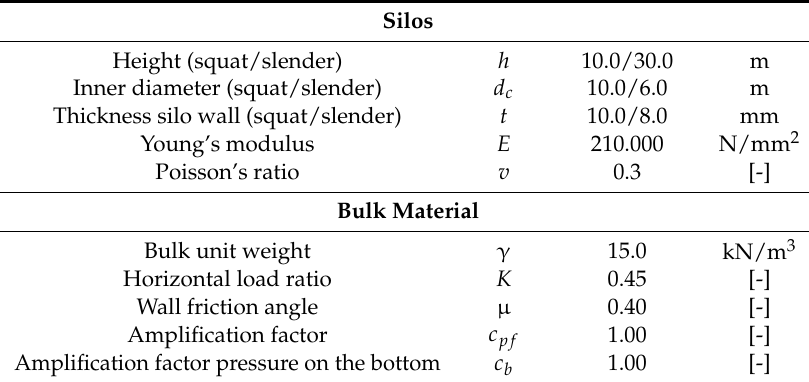
Table 1. Geometry and material parameter of the slender and squat silo.